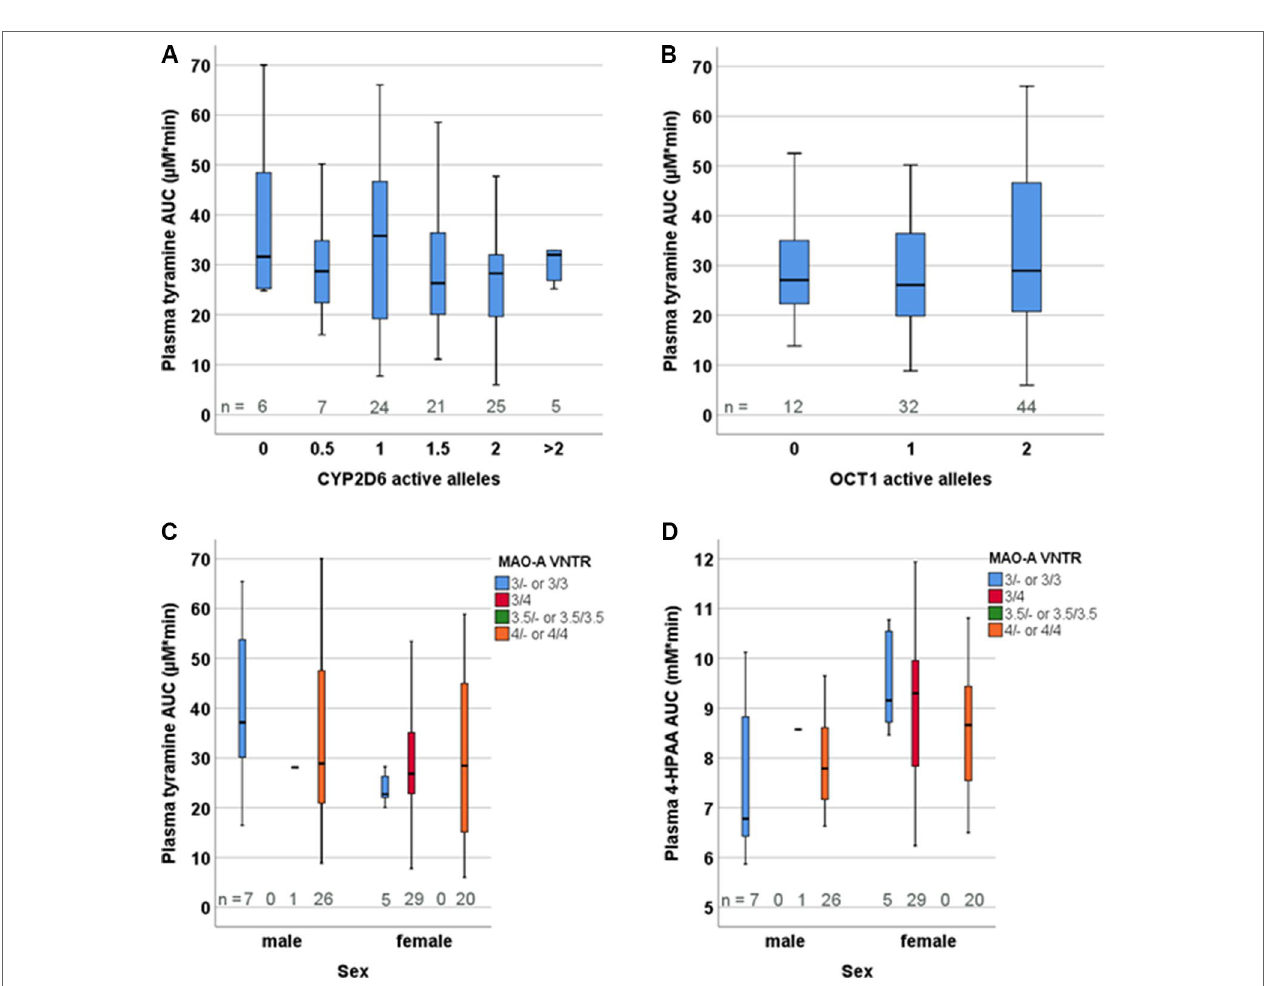
FigUre 5 | Distribution of tyramine plasma AUCs based on the genotypes of (A) CYP2D6, (B) OCT1, and (C) MAO-A VNTR. (D) Distribution of 4-HPAA plasma AUCs in relation to the MAO-A VNTR genotype.